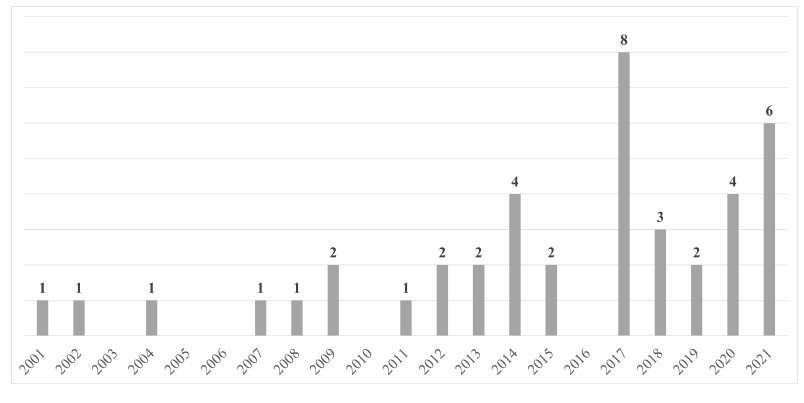
Figure 2. Year of publications.